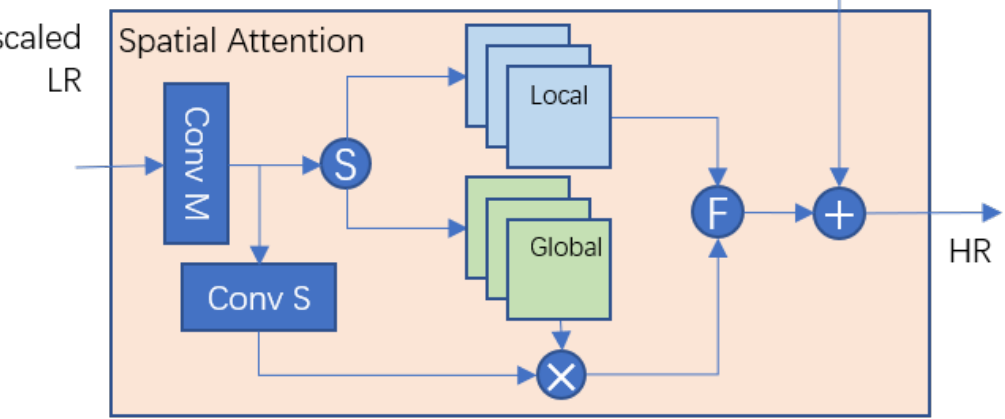
Figure 4. Reconstruction net with spatial